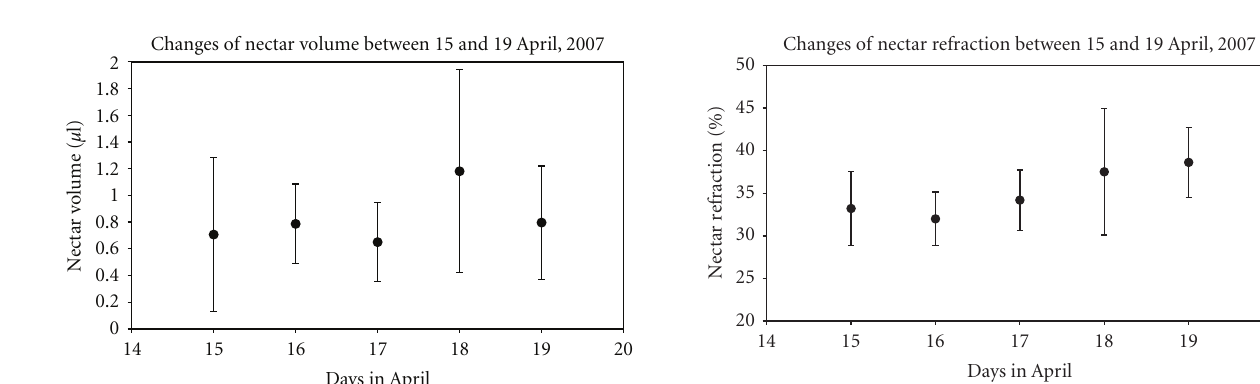
Figure 1: Nectar volume (mean and standard deviation) in covered ramson flowers at site 3, on five consecutive days of full bloom in April 2007.